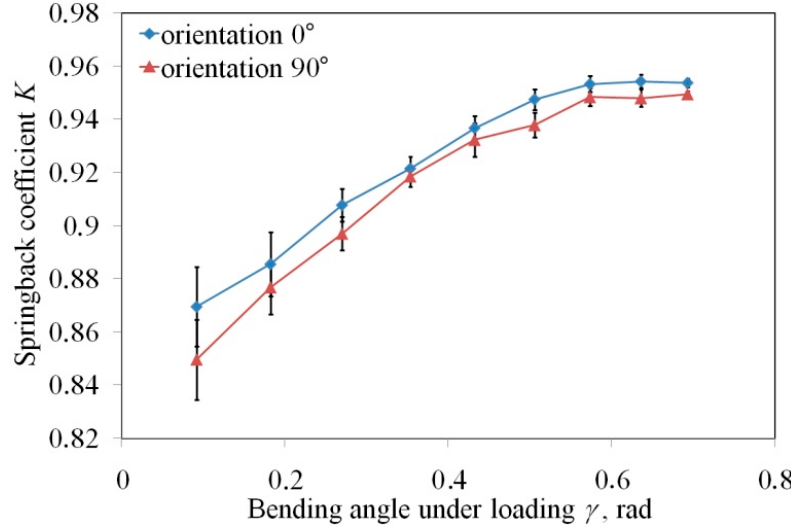
Figure 4. E ff ect of specimen orientation on the springback coe ffi Figure 4. Effect of specimen orientation on the springback coefficient.